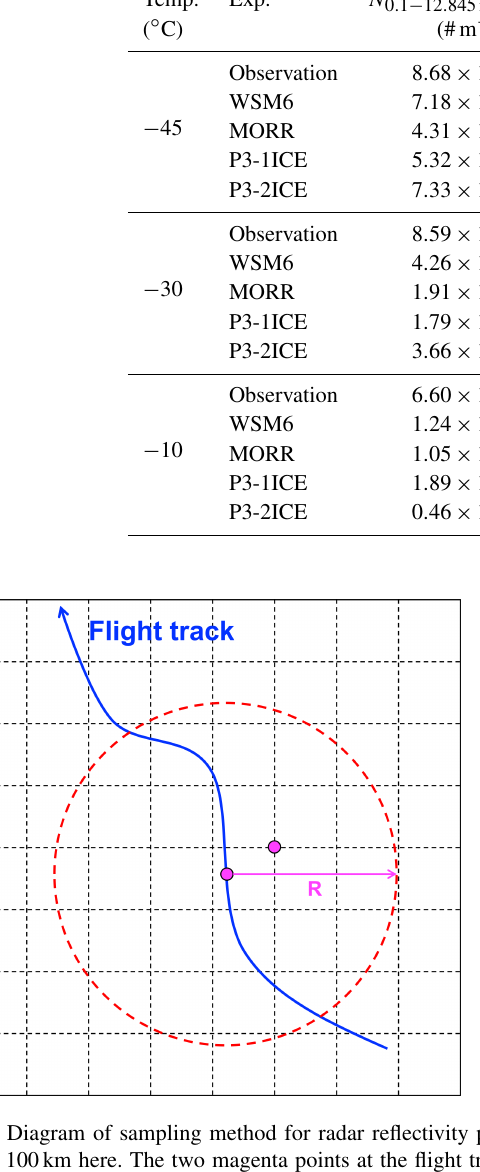
Table 1. Number concentration of median n(D) for 0.1mm < D max < 12 . 845mm ( N 0 . 1 − 12 . 845mm ) and contributions of small (0.1 mm particles at − 45, − 30, and − 10 ◦ C. The bold text indicates the dominant contribution. Temp.